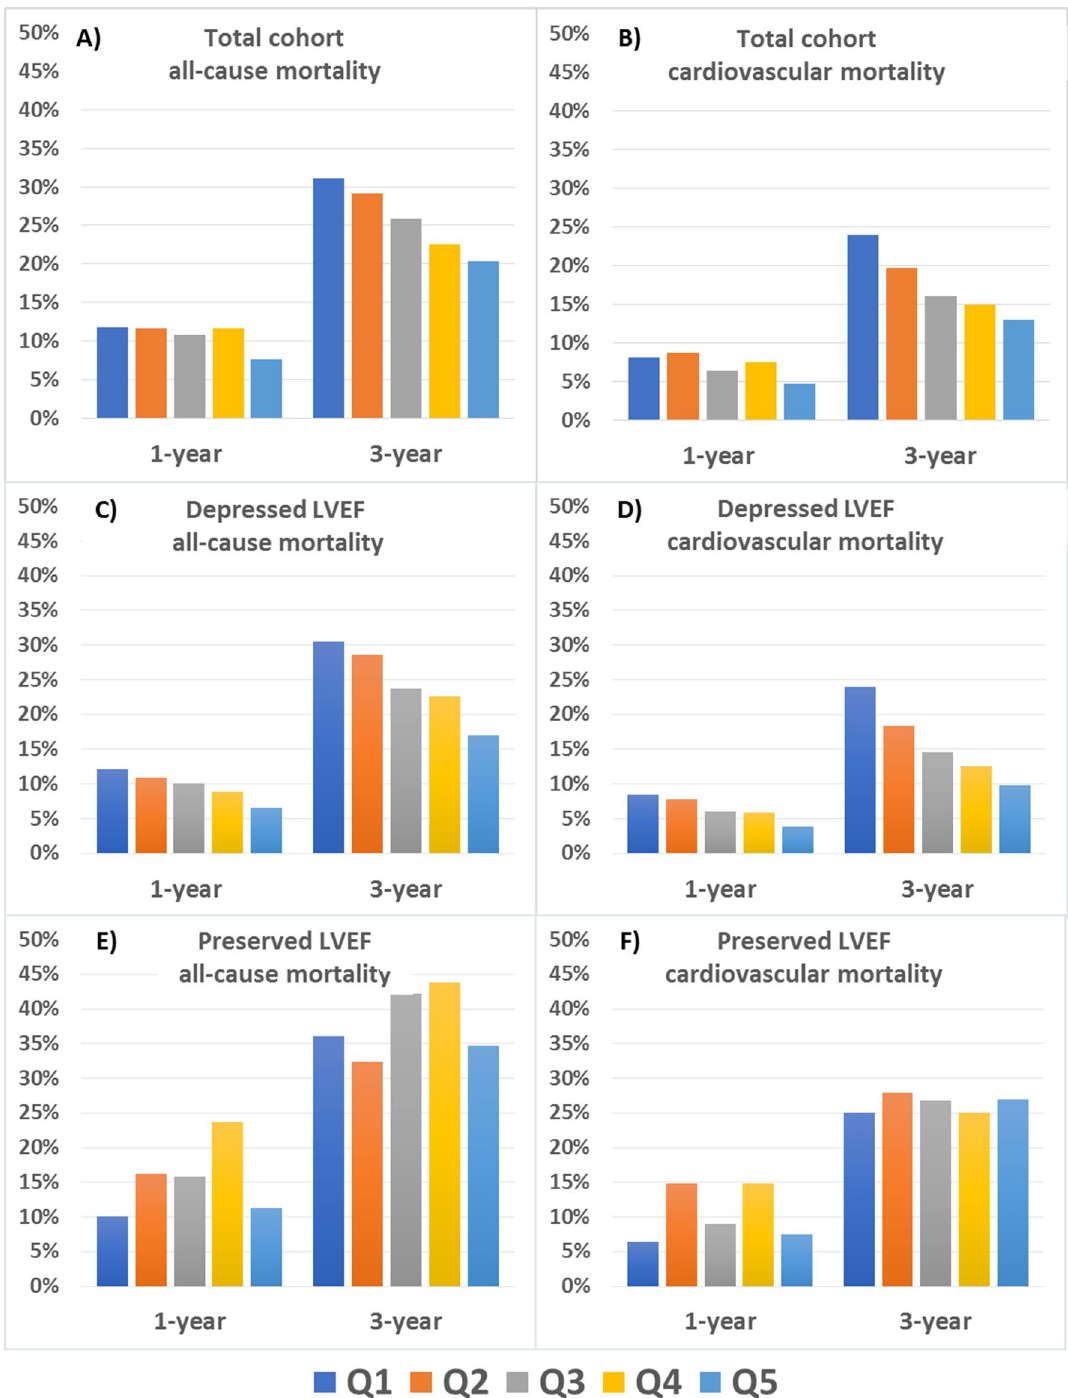
Figure 2. Trends in all-cause and cardiovascular mortality based on quintiles of period of admission. Upper panel, total cohort; middle panel, patients with depressed LVEF; bottom panel, patients with preserved LVEF. ( A , C , E ) All-cause death; ( B , D , F ) Cardiovascular with depressed LVEF, we found a progressive decrease in both all-cause and cardiovascular death rates at 1 year (from 12.1% in Q1 to 6.5% in Q5, p = 0.003; and from 8.4% in Q1 to 3.8% in Q5, p = 0.007, respectively); and 3 years (from 30.5% in Q1 to 17.0% in Q5, p = 0.003; and from 23.9% in Q1 to 9.8% in Q5, p = 0.003, respec- tively). Almost all of these trends remained significant after adjusting for confounding factors and risk: all-cause mortality at 1 year (model 1, p = 0.003; model 2, p = 0.04) and 3 years (model 1, p = 0.003; model 2, p = 0.03), and cardiovascular mortality at 1 year (model 1, p = 0.007; model 2, p = 0.05) and 3 years (model 1, p = 0.003; model 2, p = 0.02; Table 3). Conversely, in the preserved LVEF subgroup, all-cause mortality rates at 1 and 3 years